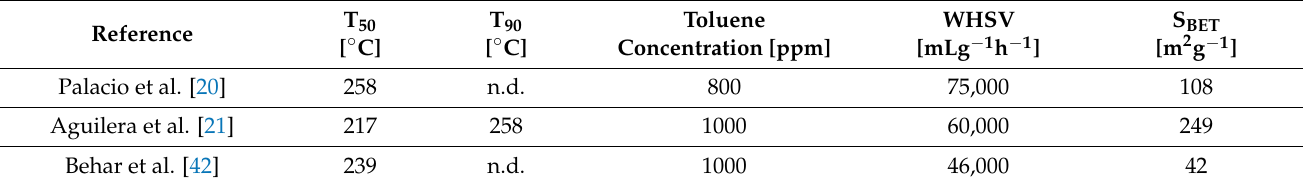
Table 3. Comparison of literature data on the catalytic combustion of toluene over variously prepared Cu–Mn mixed-oxide catalysts. (WHSV—weight hourly space